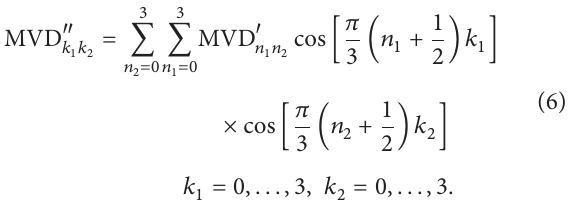
(3) Decode MB syntax of P slice. Only the P MBs containing four 8 × 8 sub-MBs are selected. Find the right bottom sub-MB (8 × 8) and read motion vectors of the right bottom subpartition if subpartition exists. In Figure 8, the horizontal motion vector residuals of shadowed partition are used to embed watermark. (4) Take a line as a unit and start searching from the right bottom corner of the slice. If we succeed to collect 8 P MBs, continue to search the next line until we gather 32 MBs (4 lines are needed):